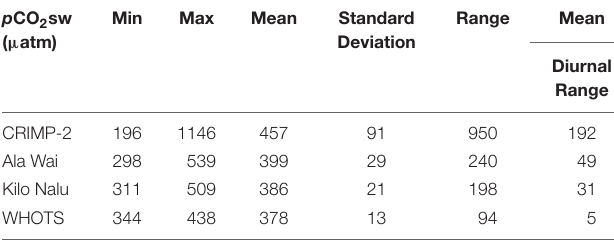
TABLE 1 | Descriptive statistics for seawater p CO 2 ( p CO 2 sw) at CRIMP-2, Ala Wai, Kilo Nalu, and WHOTS for the entire study